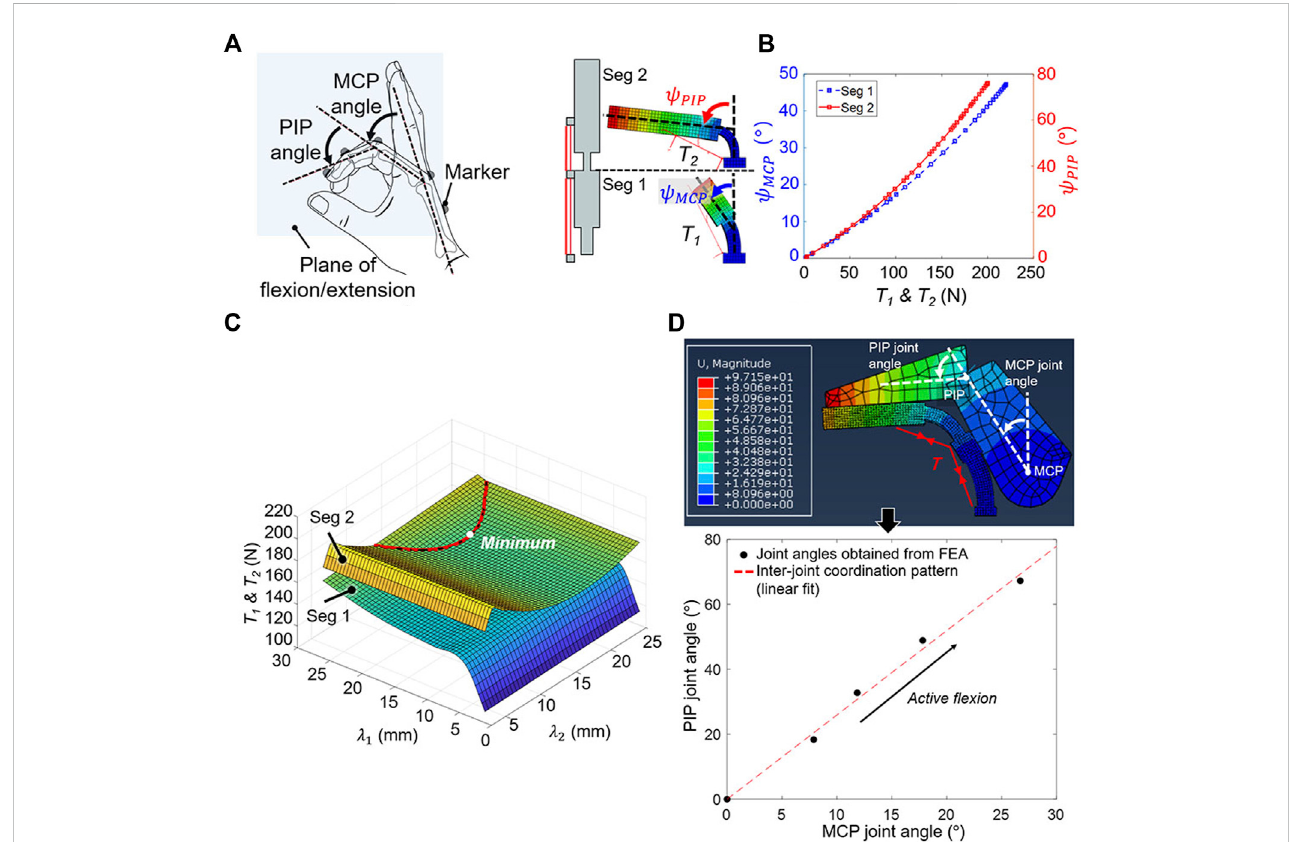
FIGURE 6 Finding the optimal solution among stiffness solutions that minimizes the assistive force for active fl exion. (A) The MCP and PIP joint ROMs of the unaffected hand during tripod grasping were measured by capturing the 3D trajectories of the re fl ective markers. (B) The relationship between the assistive force ( T 1 , T 2 ) and beam de fl ection angle ( ψ MCP , ψ PIP ) was obtained via FEA of each beam segment ( Seg 1 , Seg 2 ) of the stiffness solutions, where the segment wasdivided bytheposition ofthePDC. (C) Theassistive force thatyields thesame beamde fl ectionangles astheROMmeasurementswascalculatedfor the stiffness solutions. The optimal stiffness solution required minimal assistive force. λ 1 ; λ 2 represent the longitudinal lengths of the soft regions of the stiffnesssolutions. (D) Anindividualhand-beammodeltoobtaintheinter-jointcoordinationpatternofjointangles duringactive fl exion.Thebeamhavingthe optimal stiffness solution was de fl ected under the assistive force ( T ), and fi nger joint angles when the fi nger makes contact with the beam were obtained.